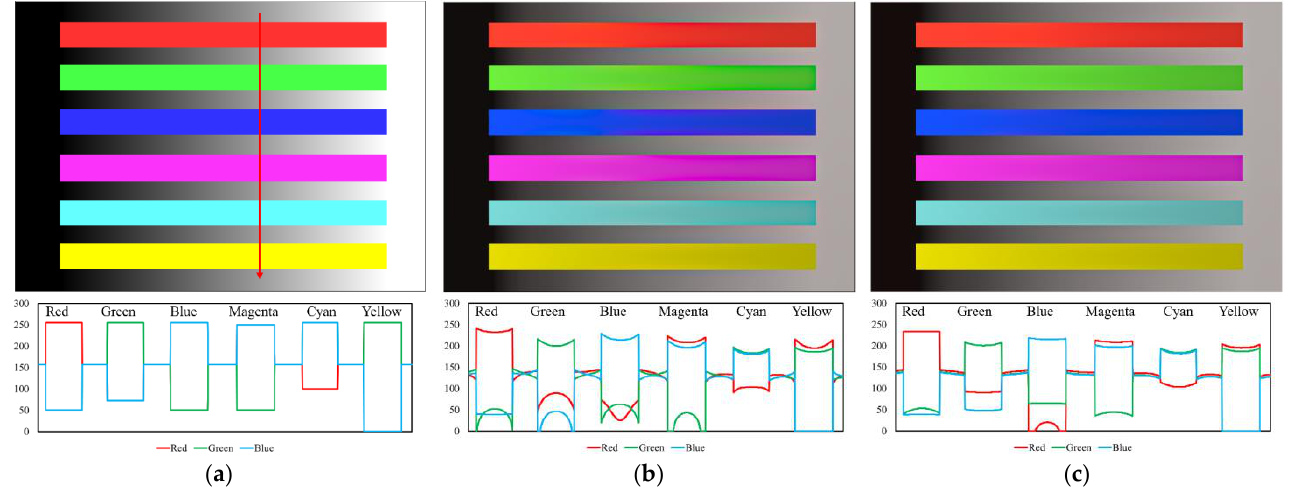
Figure 6. Rendering result of each method for test pattern #1; ( a ) input image; ( b ) iCAM06; ( c ) proposed method. Red arrow in ( a ) indicates the pixel scanline for each method. In the second row, the graph represents distribution of RGB pixels corresponding to the red arrow for each method.